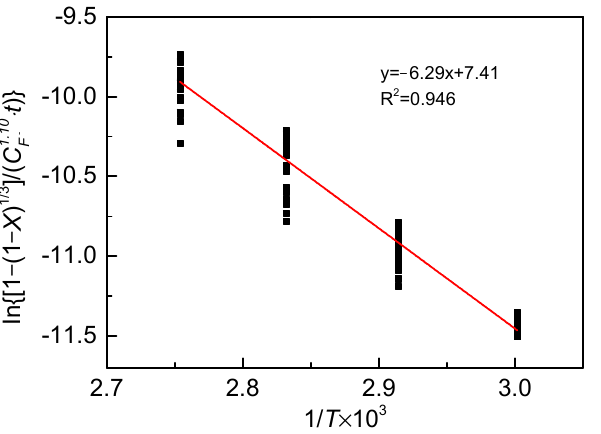
· t} versus 1/T × 1000 with L / S ratio of 20:1 and rotating C F − − ·t} versus 1/T × 1000 with L / S ratio of 20:1 and rotating speed F